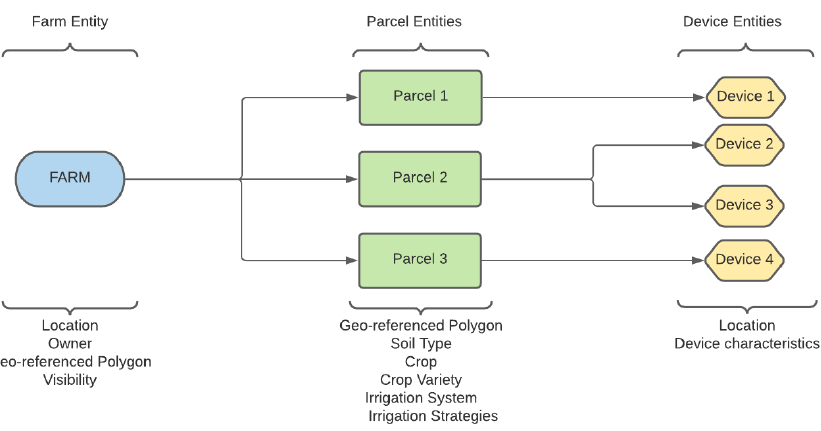
Figure 5. Structure of the entities.